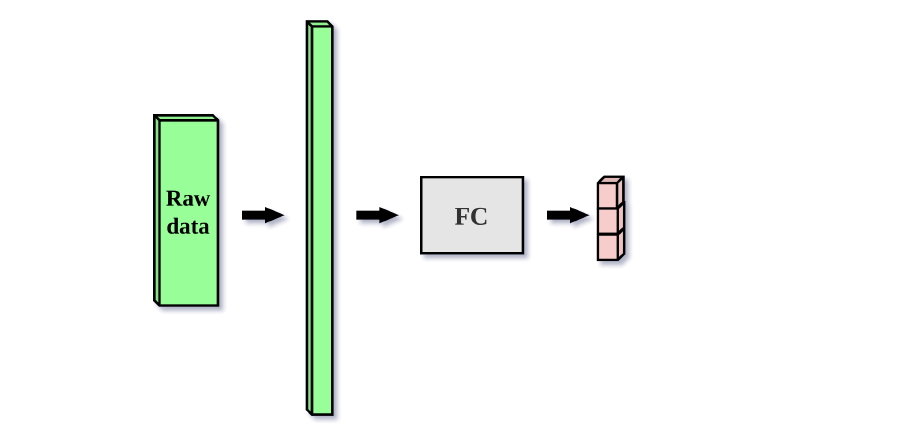
Figure 7. Single-layer fully connected neural network classifier for raw data. The input matrix of dimensions (1024, 30, 1) is flattened into a vector of 30,720 elements. The vector is then fed to a fully connected classifier with the sigmoid activation function, which produces an output vector size 3 which represents three posterior probability distributions P ( Y i = 1 | x ) , where i ∈ { aluminium , glass , plastic } .